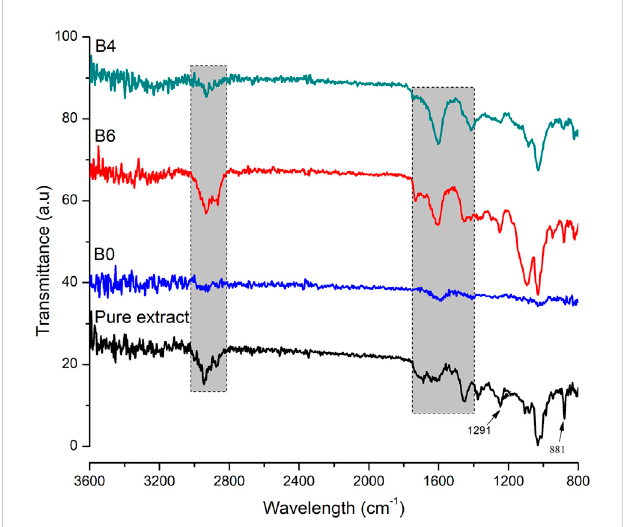
FIGURE 3 FTIR spectra of pure extract, blank (B0), B6, and B4. The shaded region shows important peaks of extract.